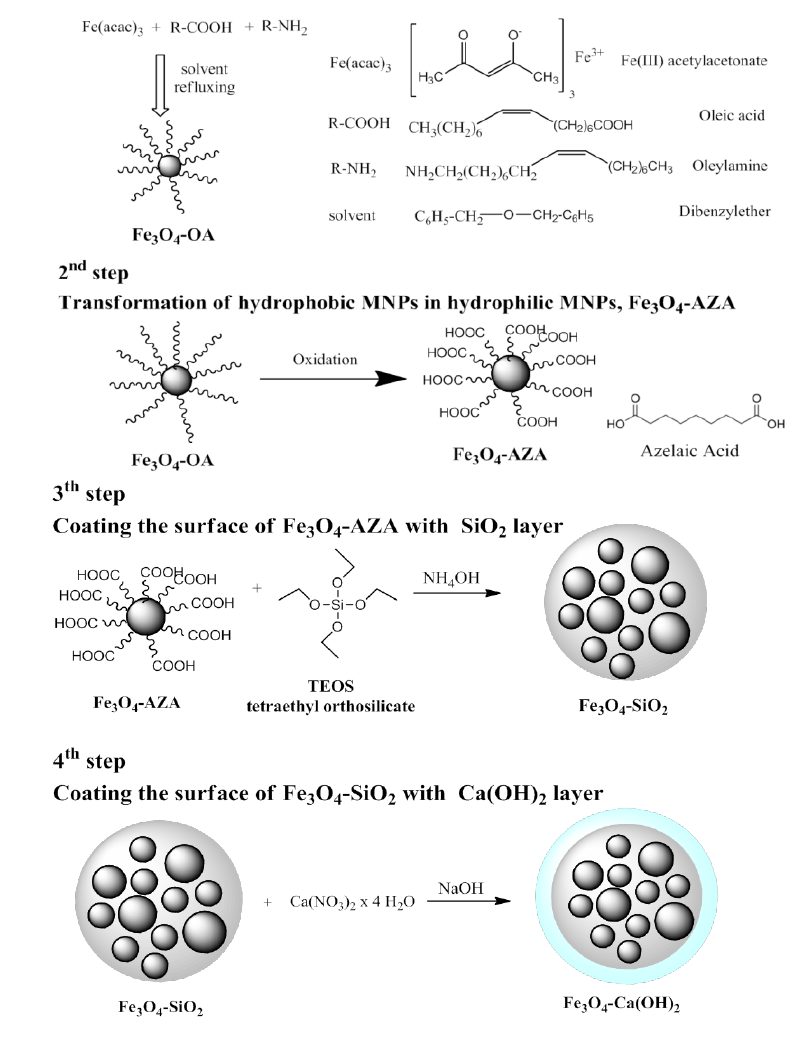
Scheme 1. Schematic representation of magnetic dental composite material